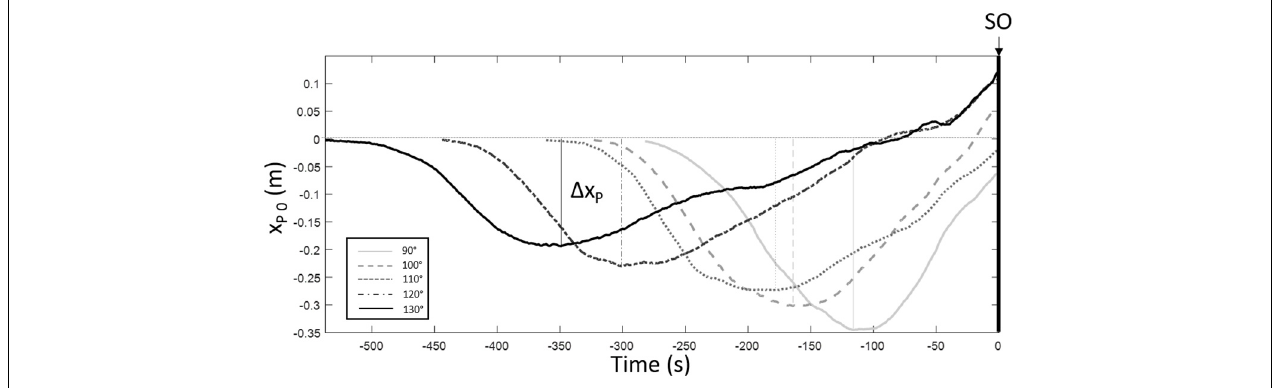
FIGURE 7 | Displacement of x p during the postural phase (until SO, seat-off time) as a function of time for one subject for the 5 backrest